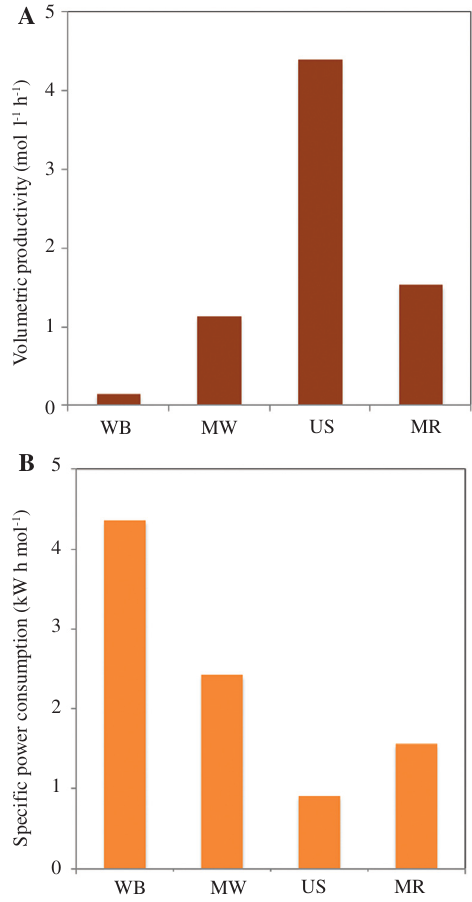
mmim][Br] synthesis performed by Figure 6 Comparison of [C 7 different techniques: (A) volumetric productivities and (B) specific power consumptions. Experimental conditions were the same as described in Figure 3. Abbreviations denominate processes performed by the application of: WB, conventional batch reactor with reflux thermostated by means of a water bath; MW, microwave irradiation; US, ultrasonication; MR, a